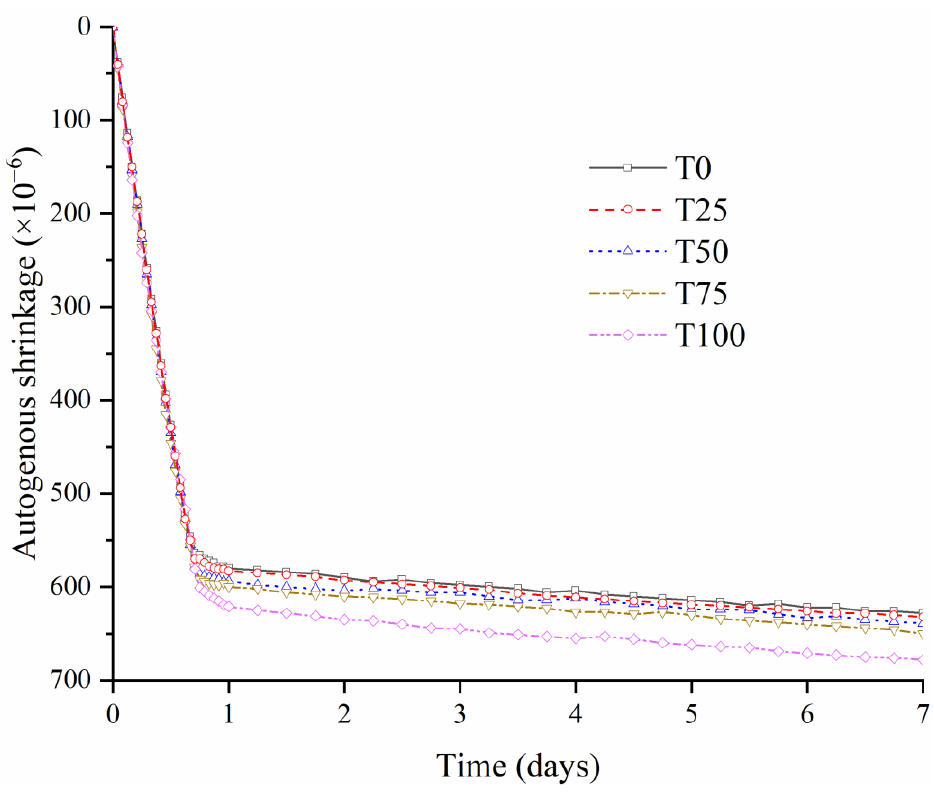
Figure 13. Effect of iron tailings on the autogenous shrinkage of UHPC.